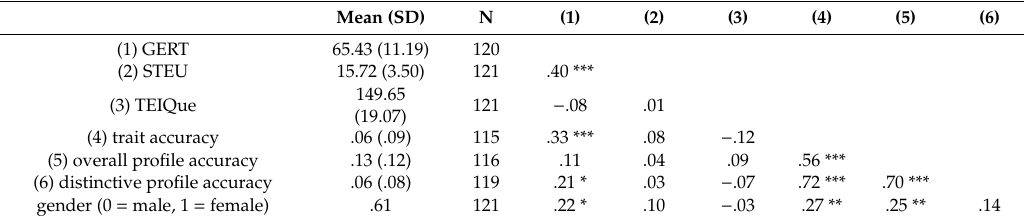
Table 1. Descriptive Statistics and Intercorrelations (Spearman Rank Correlations) of Main Study